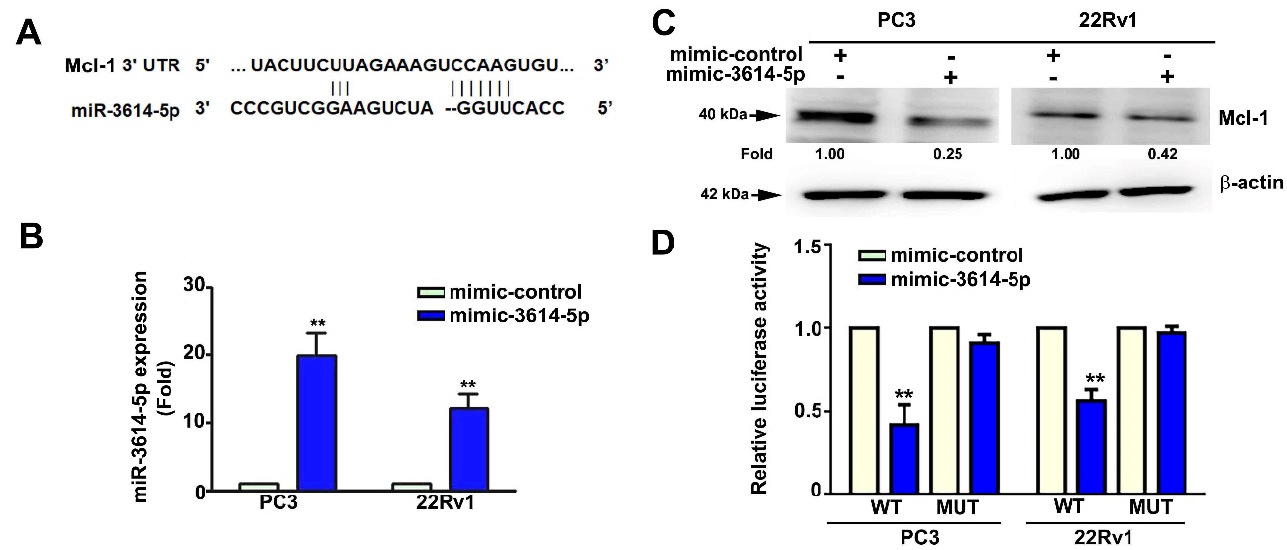
Figure 5. Effect of miRNA-3614-5p on Mcl-1 expression in human PC3 and 22Rv1 prostate cancer cells. ( A ) The miRNA-3614-5p targeting sites on the 3 ′ UTR of Mcl-1. ( B ) The expression of miRNA- 3614-5p in human PC3 and 22Rv1 prostate cancer cells transfected with mimic-control or mimic- 3614-5p were measured by qRT-PCR assay, with GAPDH as a loading control. ( C ) The level of Mcl-1 protein in human PC3 and 22Rv1 prostate cancer cells transfected with mimic-control or mimic-3614-5p were measured by immunoblotting assay. β -actin was used as a protein loading control. ( D ) Luciferase activity of the luciferase reporter constructs containing either the WT or Mut-3 ′ -UTR of Mcl-1 promoter following mimic-control or mimic-3614-5p transfection in human PC3 and 22Rv1 prostate cancer cells. **, p < 0.01 versus control (mean ± SE, n = 3). Mimic-3614-5p as mimic miRNA- 3614-5p